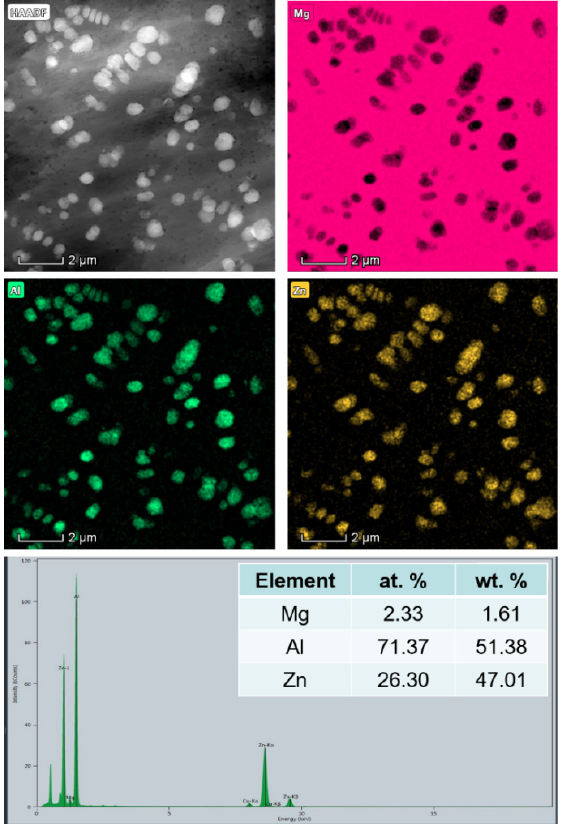
Figure 5. HADDF-STEM image of as-cast LAZ1366 alloy and its elemental mapping.